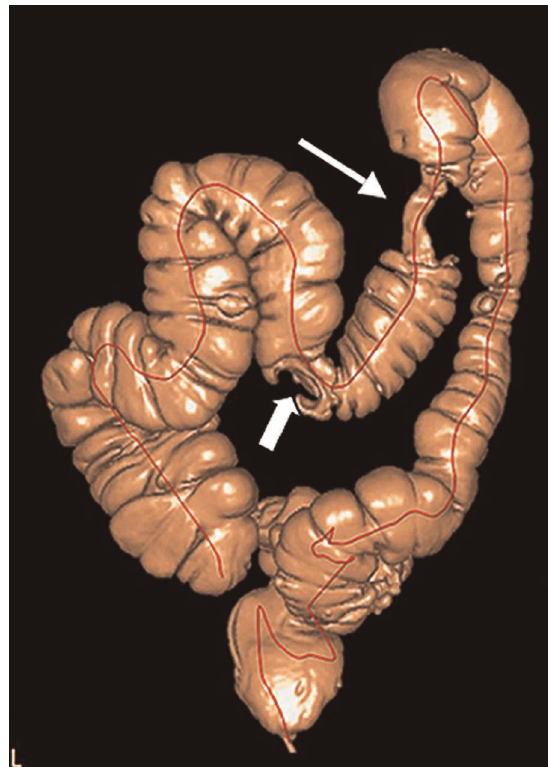
Figure 1 - CTC volume rendering showing a synchronous tumor of the transverse colon (large arrow). In this patient, the colonoscopy was unable to overcome the stenotic and infiltrat- ing lesion located in the splenic angle (thin arrow).